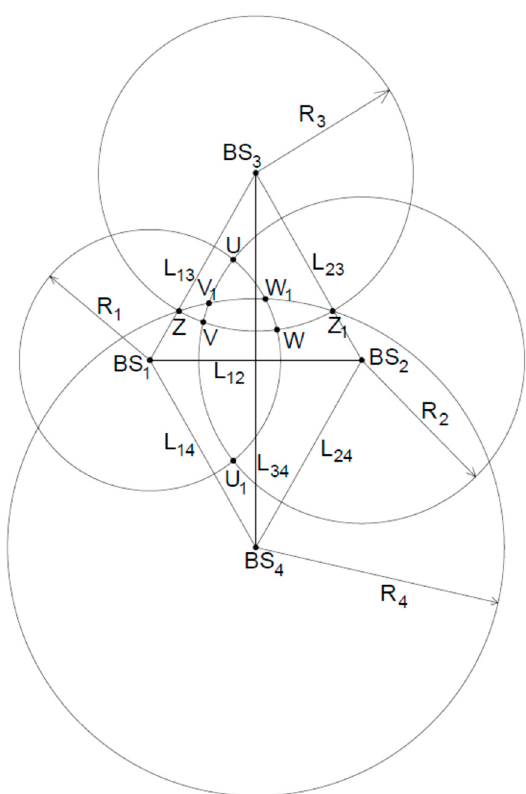
Figure 1. Location geometry with the four TOA circles [24].